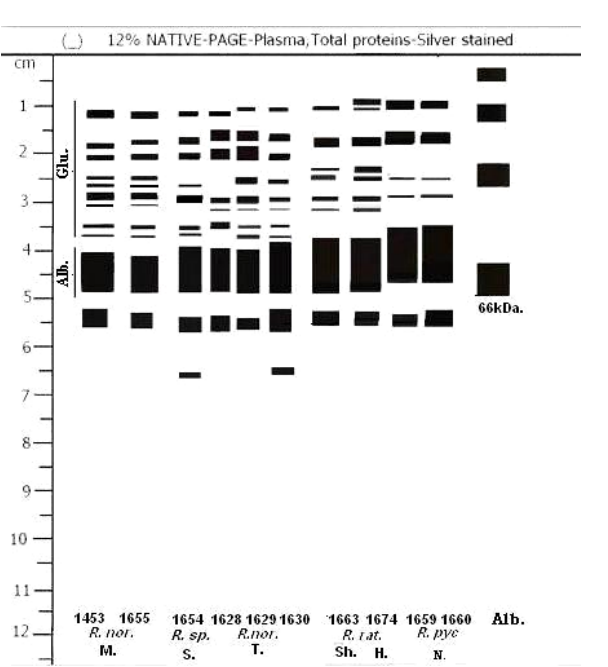
F IGURE 2. Native-PAGE patterns of plasma proteins of Rattus . R. norvegicus from Mashhad (FUMZM 1453, FUMZM 1655), R. norvegicus from Tehran (FUMZM 1628, FUMZM 1629, FUMZM 1630), Rattus sp. from Semnan (FUMZM1654), R. rattus from Shiraz (FUMZM1663), R. rattus from mangrove forests (FUMZM 1674), R. pyctoris from Noghondar (FUMZM 1659, FUMZM 1660), and Alb marker. ♂ : male, ♀ : female. T ABLE 1- Numeric values of electrophoretic bands of total proteins and esterase-1 of